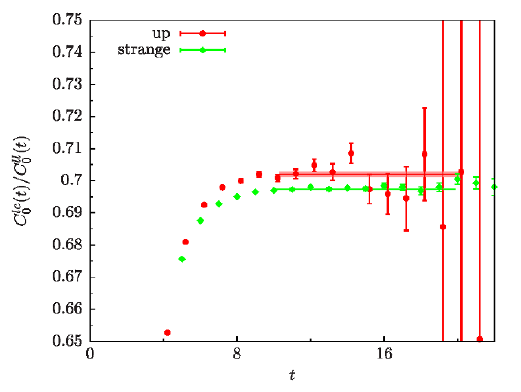
Figure 15 . The ratio of the local-conserved and local-local vector two-point function without QED for up (red circles) and strange (green